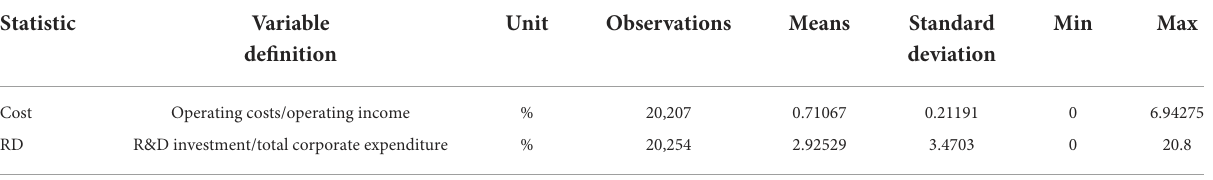
TABLE 9 Descriptive statistics of the mediating variables.